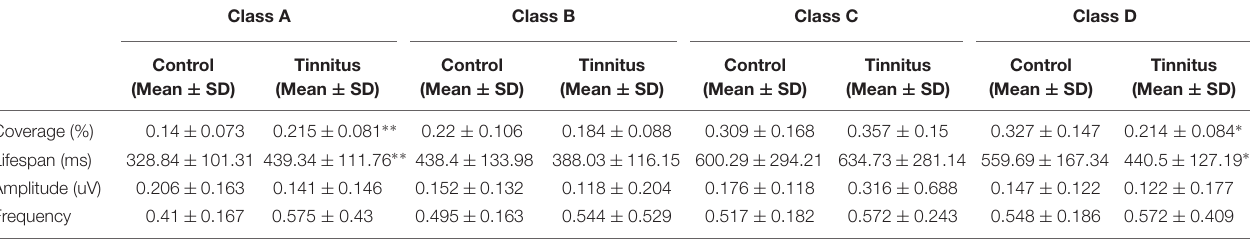
FIGURE 1 | The spatial configuration of the four classes of microstates in the control group and tinnitus group. TABLE 2 | Comparison of the microstate analysis results in patients with tinnitus and control subjects. Class A Class B Class